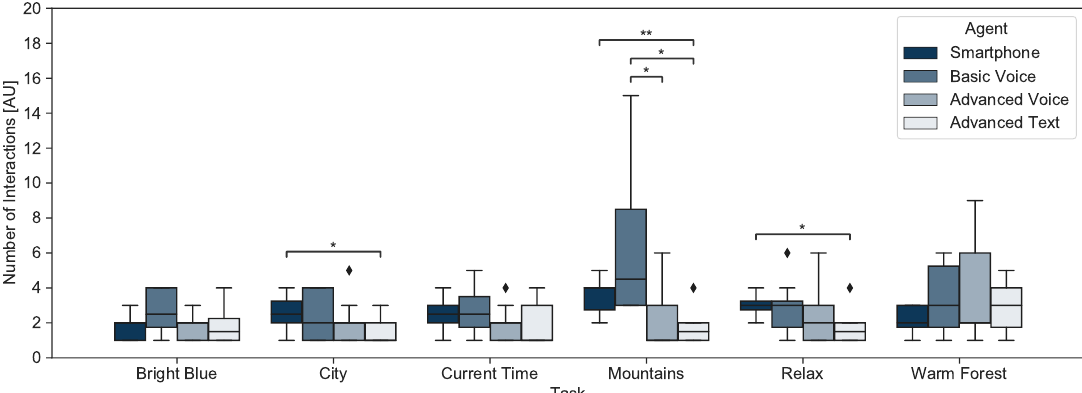
Figure 8. Number of interactions per task and agent during Part II. Note: * p < 0.05, ** p < 0.01, *** p <